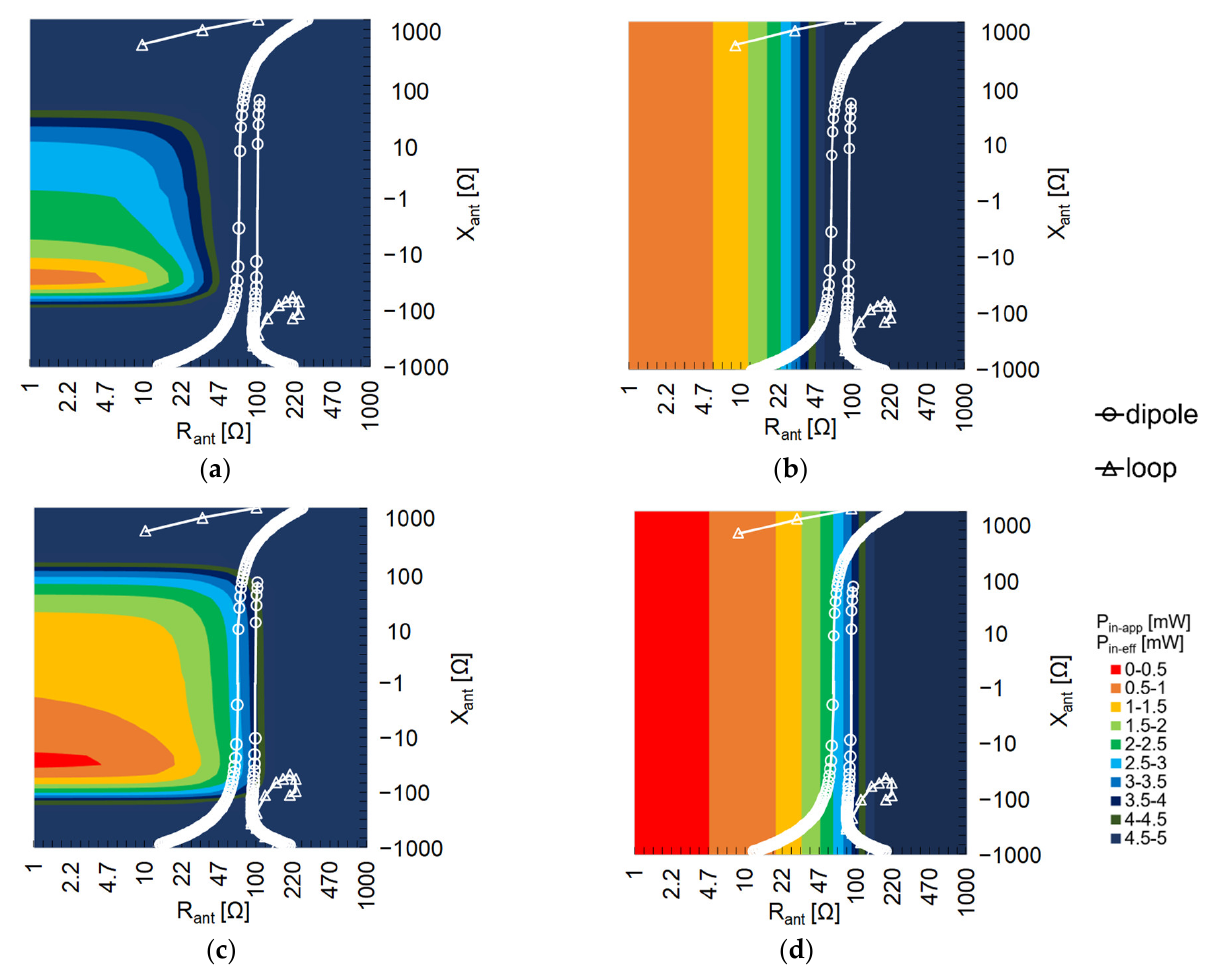
Figure 14. Contour plots of input power with Model 2 at P out = 100 µ W: ( a ) P in − app (SD), ( b ) P in − ef f (SD), ( c ) P in − app (VD), ( d ) P in − ef f (VD).